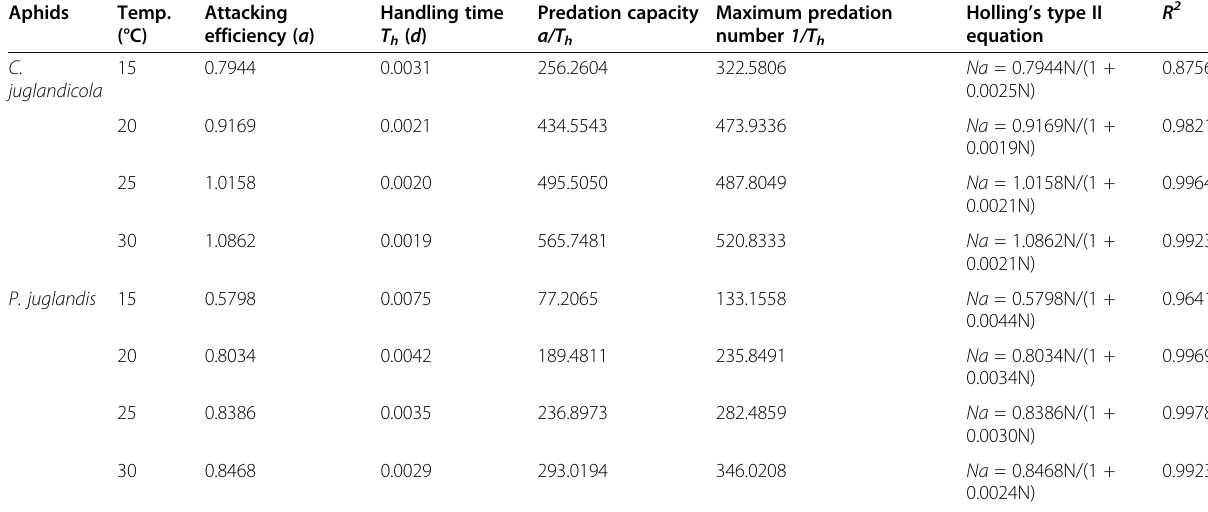
Table 1 Functional response of H. axyridis on C. juglandicola and P. juglandis under four different temperature regimes Aphids Temp. (°C)